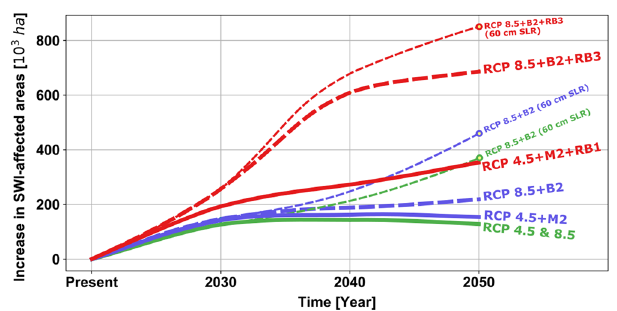
Fig. 4 Projected increasing trends of areas affected by saline water under various environmental pathways for the Mekong Delta. Projections of increase in SWI-affected area within the VMD under various combinations of scenarios of climate change projections (RCP 4.5 and 8.5), land subsidence (M2 and B2) and riverbed level changes (RB1 and RB3), including the case of extreme SLR in the year